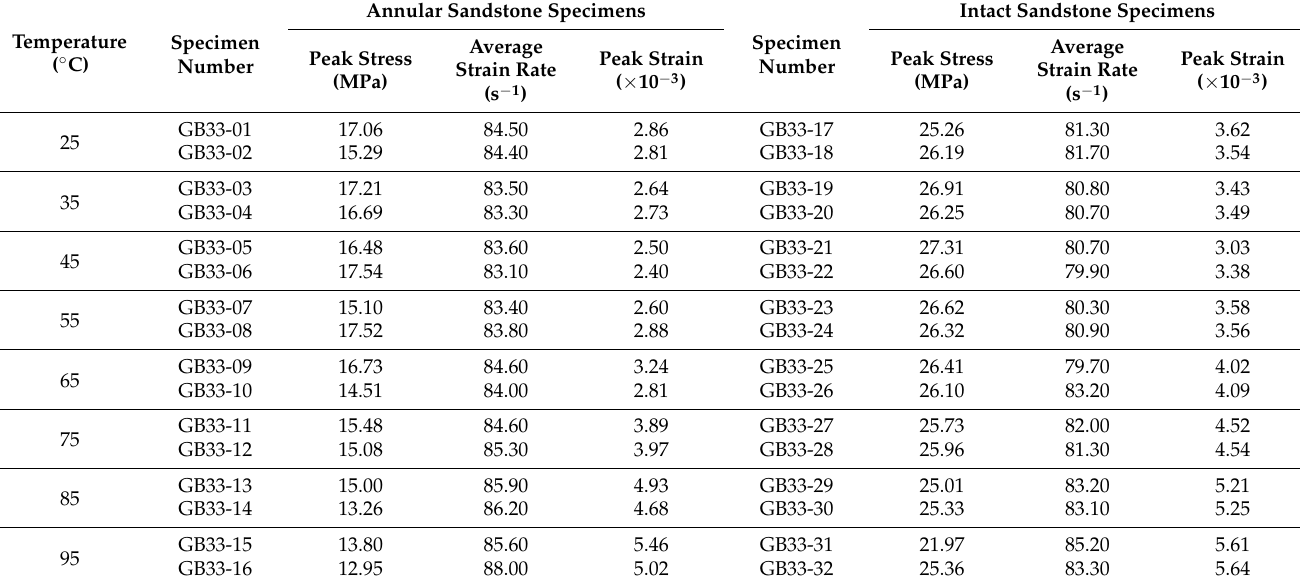
Table 2. SHPB test data.